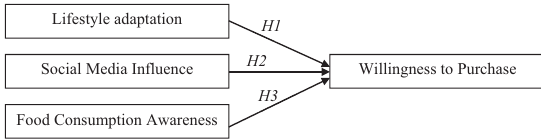
Figure 1. Research